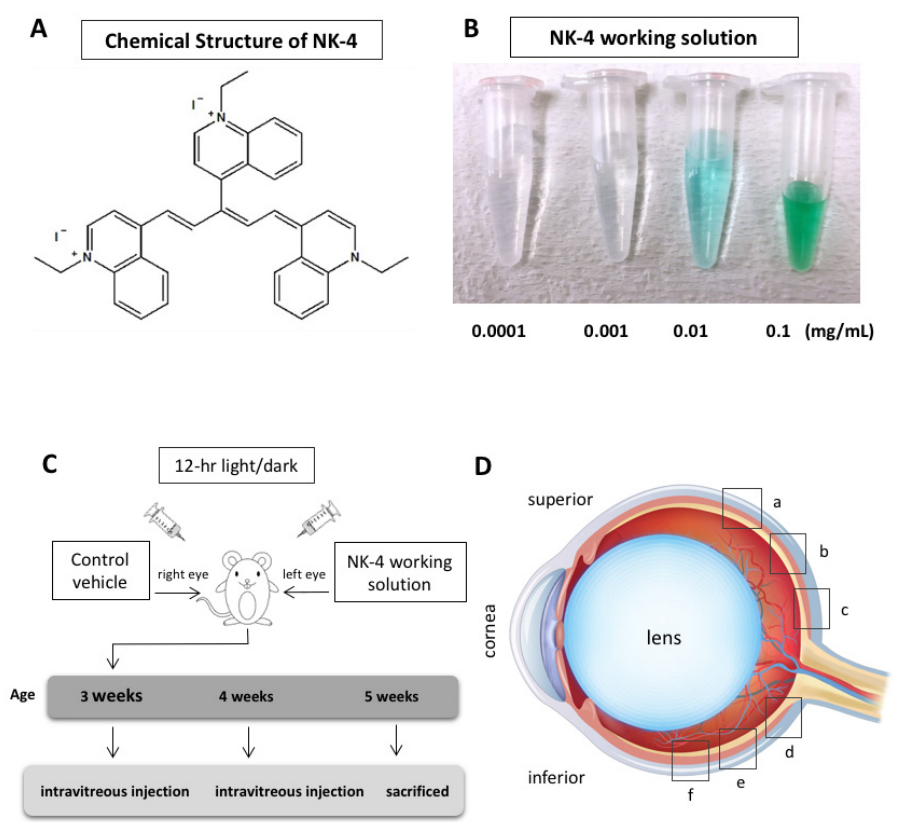
Figure 1. NK-4 and experimental design. ( A ) Chemical structure of NK-4. ( B ) A series of NK-4 working solutions with different concentrations (0.0001 to 0.1 mg/mL). ( C ) Experimental schedule. ( D ) Six retinal sites (a, b, c, d, e, and f) for TUNEL staining. The “a”, “b”, and “c” began at the straight distance of 586, 373, and 160 µ m, respectively, superior from the optic nerve head, while “f”, “e”, and “d” began at the straight distance of 586, 373, and 160 µ m, respectively, inferior from the optic nerve